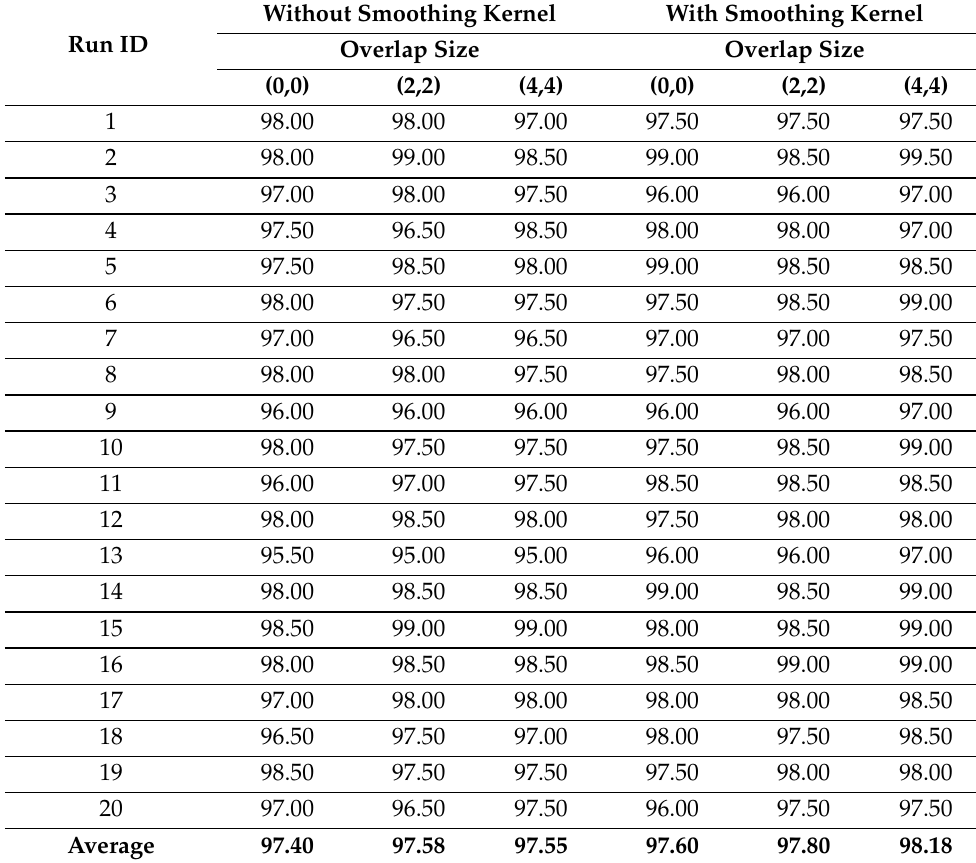
Table A8. The results of the runs for Gaussian noise with standard deviation of 0.05.